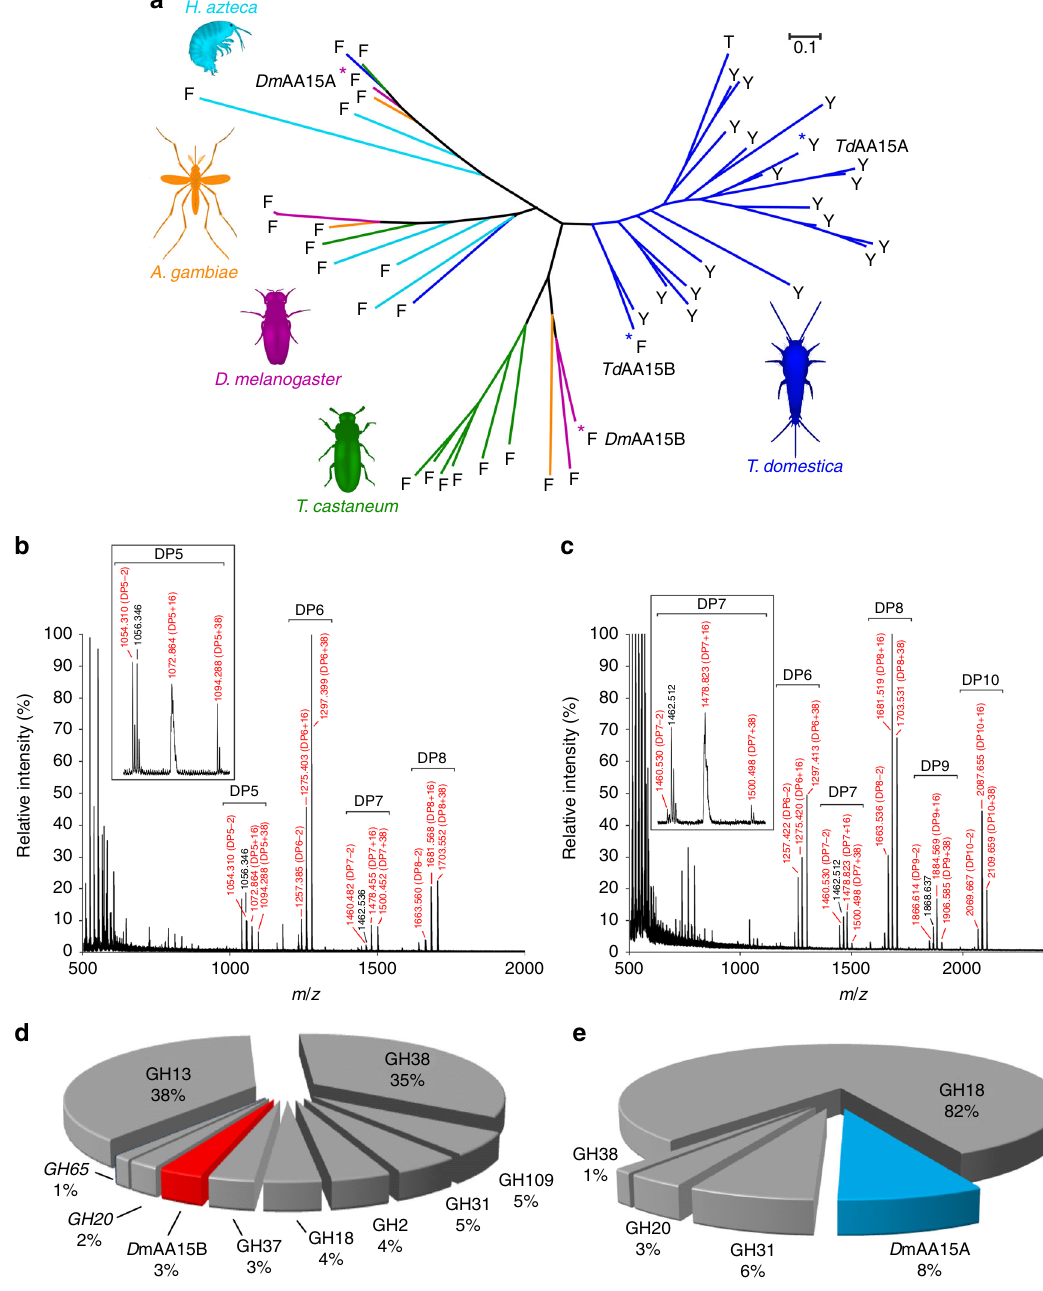
Fig. 5 Phylogeny, biochemical characterization and tissue localization of insect AA15 LPMOs. a Maximum likelihood phylogenetic tree showing the AA15 coding sequences identi fi ed in the genome of three model insect species ( D . melanogaster , T . castaneum , and A . gambiae ), one model crustacean ( Hyalella azteca ), and in the transcriptome of T . domestica (Supplementary Notes 2, 4 – 7). Each tree branch is colored according to the species. The axial residue of each protein is indicated with a letter (Y = tyrosine, F = phenylalanine, T = threonine). Blue asterisks mark Td AA15A and the Td AA15B. Magenta asterisks mark Dm AA15A and Dm AA15B. MALDI-TOF MS spectra of products obtained after incubation of 4 mg mL − 1 α -chitin ( b ) and β -chitin ( c ) with 2 µ M Td AA15B and 4 mM gallic acid for 24 h, showing native and oxidized oligosaccharides. The main peaks correspond to mono- or di-sodiated adducts of C1- aldonic acids, imparting + 16 or + 38 m/z respectively, relative to the mono-sodiated unoxidized form. Smaller peaks for the mono-sodiated lactone ( − 2) were also identi fi ed. In b and c , 100% relative intensity represents 2.9 × 10 4 and 1.3 × 10 4 arbitrary units (a.u.), respectively. Insets are expanded mass spectra for DP5 ( b ) and DP7 ( c ) products. Spectra of the negative control reactions are included in Supplementary Fig. 12c – f and do not show any native